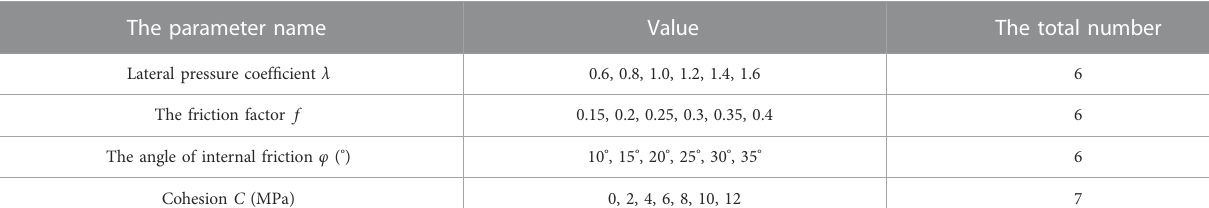
TABLE 3 Assignment of overlying strata parameters.